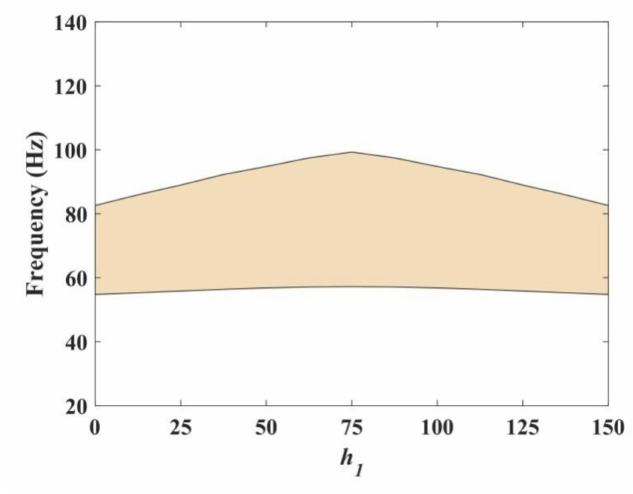
Figure 9. The influence of h 1 on the band